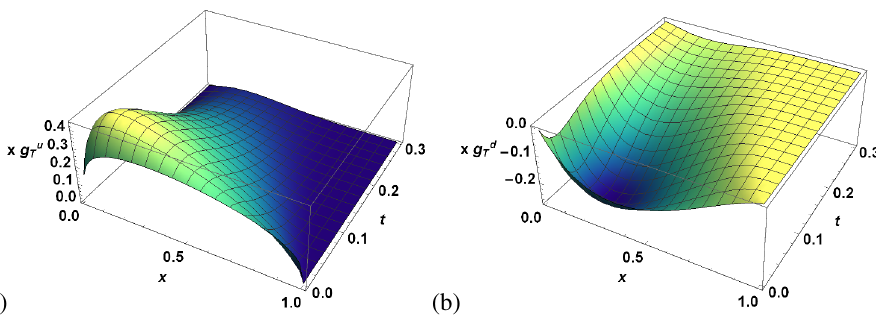
Figure 3: (Color online) 3D Plots of transversely polarized TMD x g ν x and p 2 . The left and right column correspond to up and do w n quarks respectively. ⊥